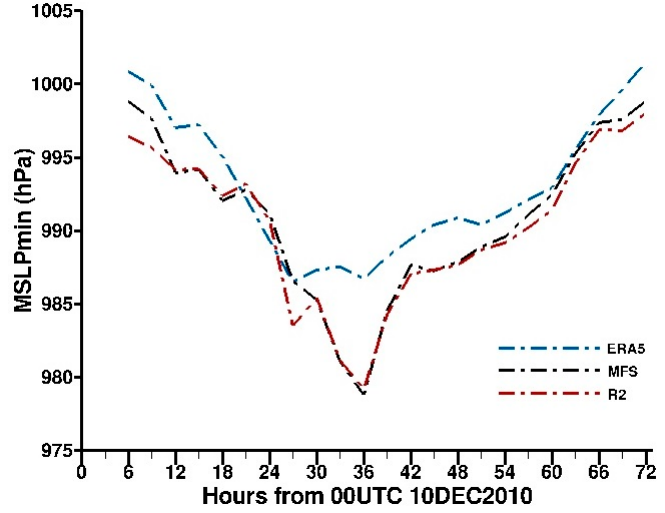
Figure 24. Time series of MSLP for the reanalysis (blue), R2 run (red) and MFS run (black). The 12 h accumulated rainfall maps during the explosive cyclogenesis phase are shown in Figure 25 for the R2 (left panel) and the MFS (right) simulations. The patterns and amounts are very similar in both the R2 and MFS runs. The maximum R2 rainfall is only 1 mm more than the MFS value. The region of the heaviest rainfall appears over the northeast corner of the Levantine basin. This location and the amounts are consistent with the analyzed TRMM values shown above in Figure 8. However, in contrast to the TRMM data, the rainfall in the model is separated into several narrower, elongated bands that extend to the west and to the south. This is most likely due to the higher resolution of the model (10 km as compared to ~25 km for TRMM). This was confirmed by a single model run with a 25 km horizontal grid in which the elongated, narrow precipitation bands merged into a larger patch, more similar in appearance to the TRMM rainfall map shown above in Figure 8 (results not shown).